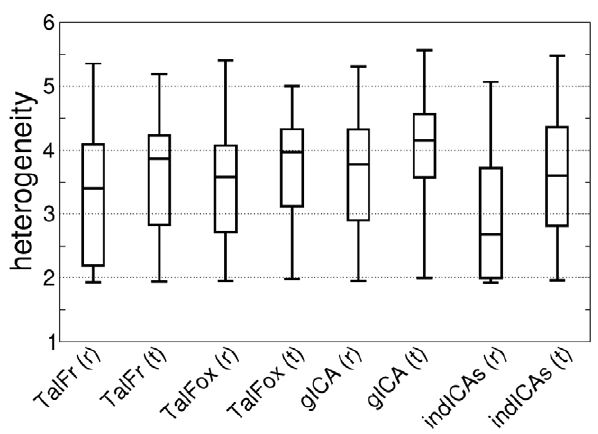
Figure 4. Within-ROI spatial functional heterogeneity as a function of method and condition. The bottom and top of the box are the 25th and 75th percentile (the lower and upper quartiles, respectively), and the band in the box is the 50th percentile (median); whiskers represent minimum and maximum values.